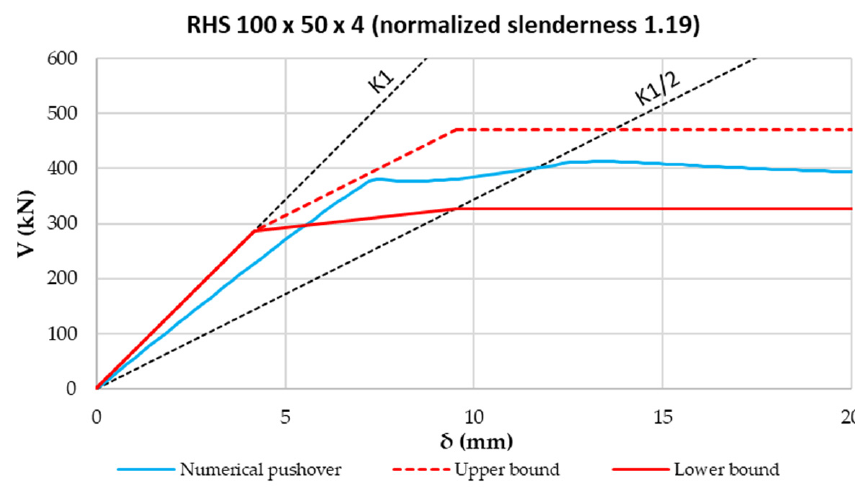
Figure 16. Comparison between analytical pushover curves and numerical one for the profile RHS 100 × 50 × 4. Some like “x” means “×”.